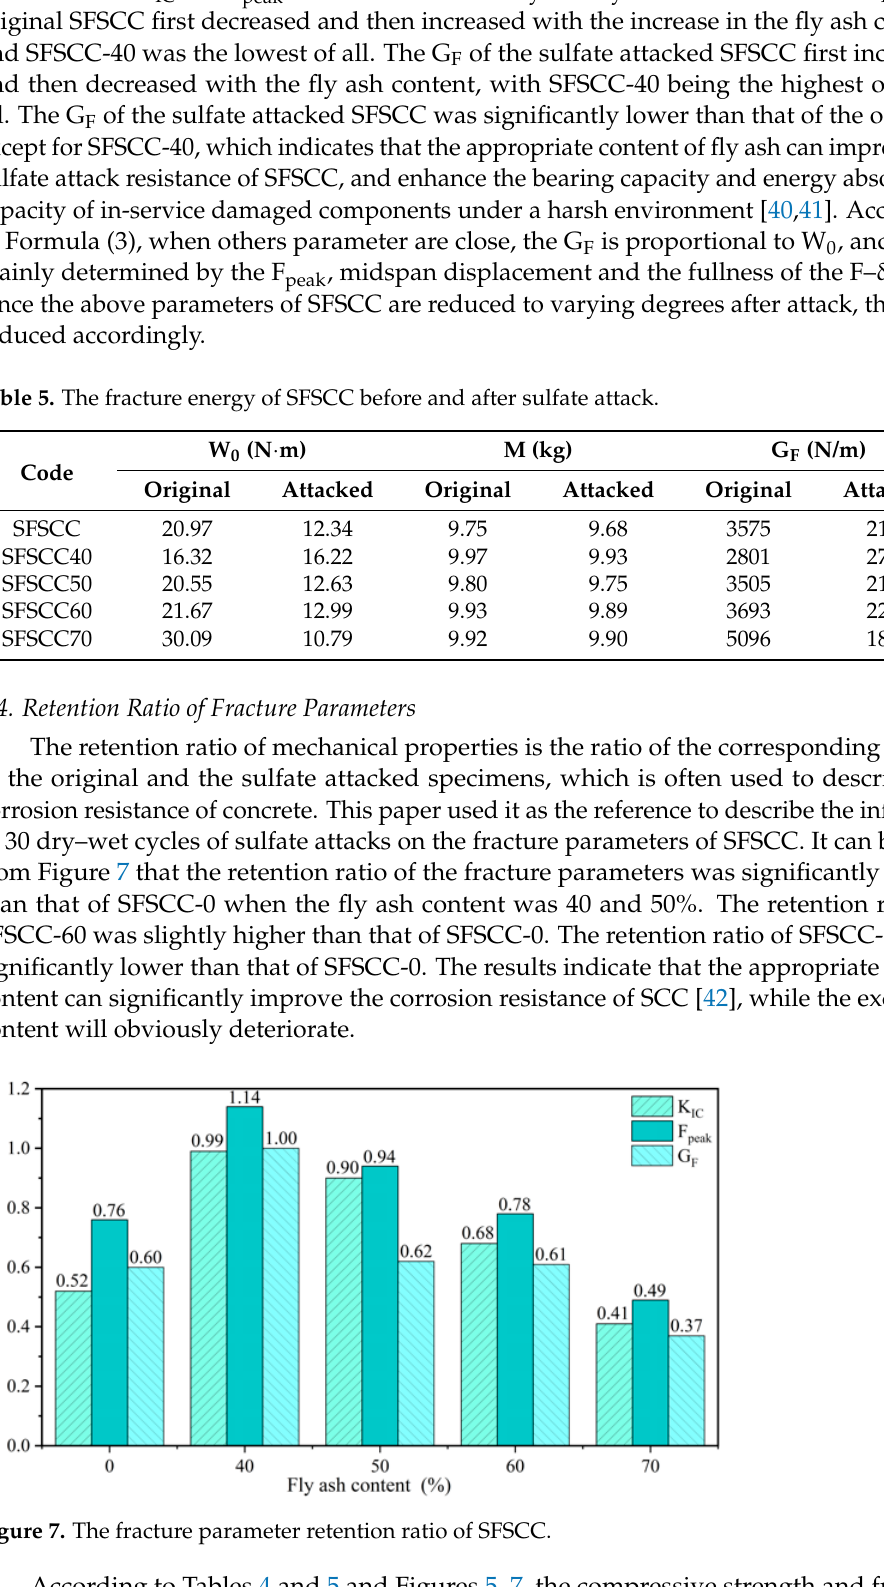
( d ) Figure 8. Section SEM images of SFSCC at 1 year. ( a ) SFSCC-0 (2000×); ( b )SFSCC-40 (2000×); ( c ) SFSCC-50 (2000×); ( d ) SFSCC-60 (2000×). It can be seen from Figure 9a that the sulfate attacked products of SFSCC-0 was fascicled acicular ettringite, and its structure was loose. The local expansion caused by the formation of ettringite led to the reduction in its fracture mechanical properties. Figure 9b shows the section of SFSCC-40 after dry–wet cycle attack, where there was some fly ash particles and fine cracks, but no obvious corrosion products, and the hardened structure matrix was dense. Figure 9c,d shows that the microstructures of SFSCC-50 and SFSCC-60 were loose after erosion, that white erosion products appeared at the interface of the hy- dration products, and the microcracks and porosity increased. No obvious erosion prod- ucts were observed in Figure 9c,d, and the cross-sectional structure of SFSCC-60 became looser.